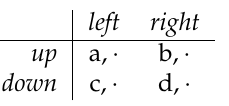
Figure 3. Material payoffs for best response